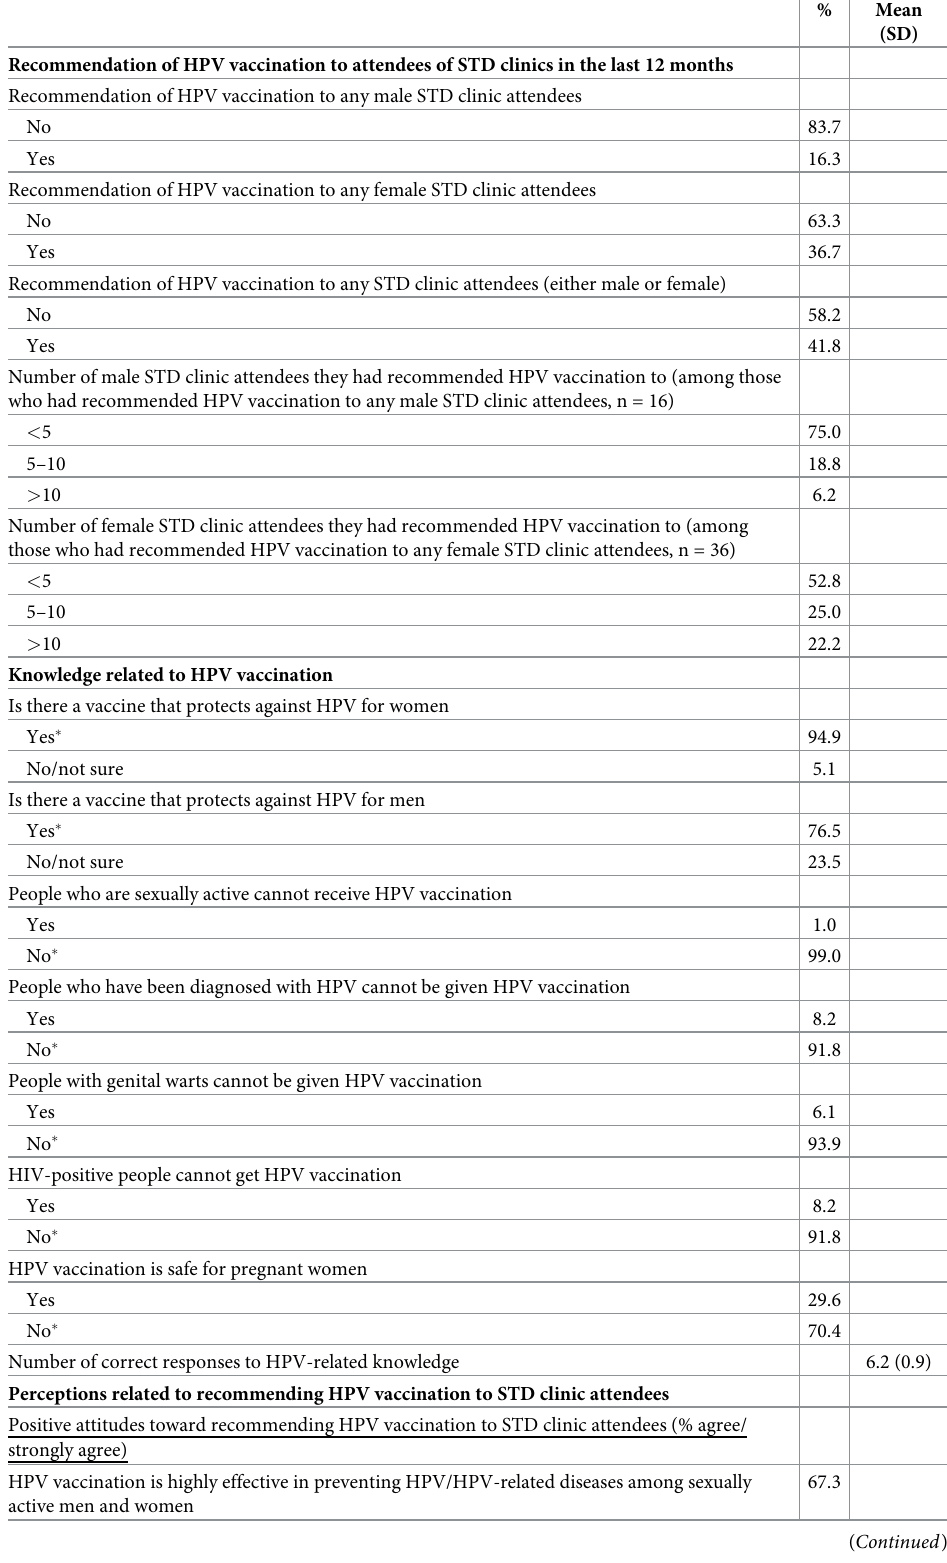
Table 2. Knowledge and perceptions related to HPV vaccination (n =